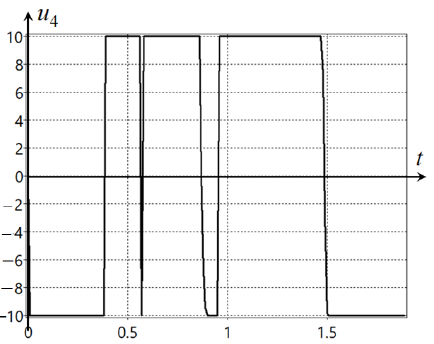
Figure A10. Plot of optimal values of control component u 4 .